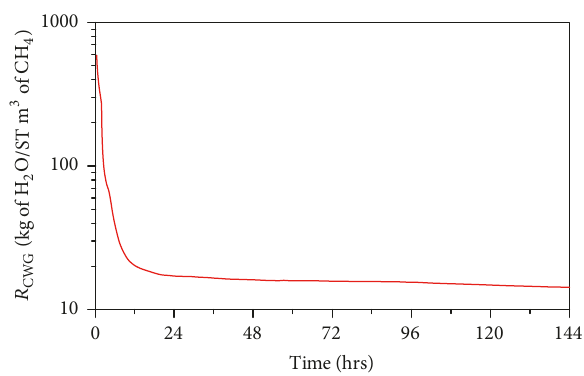
Figure 10: The cumulative water/gas ratio 𝑅 CWG during the 6-day production test at the AT1 site.